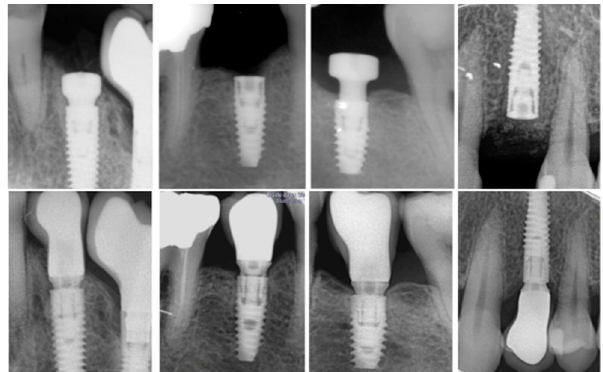
Figure 1. Periapical radiographs with an intraoral dental film using a plastic index according to the parallel technique for marginal bone loss (MBL) analysis between baseline and 1 year follow-up.